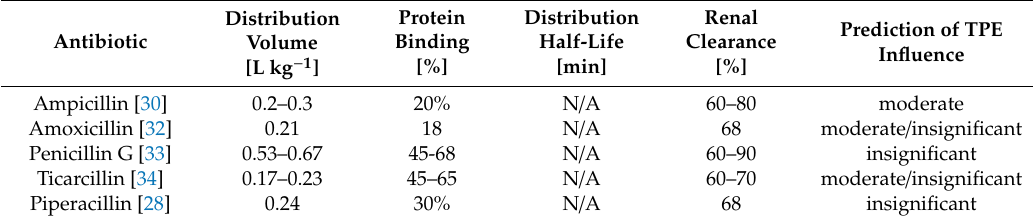
Table 1. Therapeutic plasma exchange (TPE) and